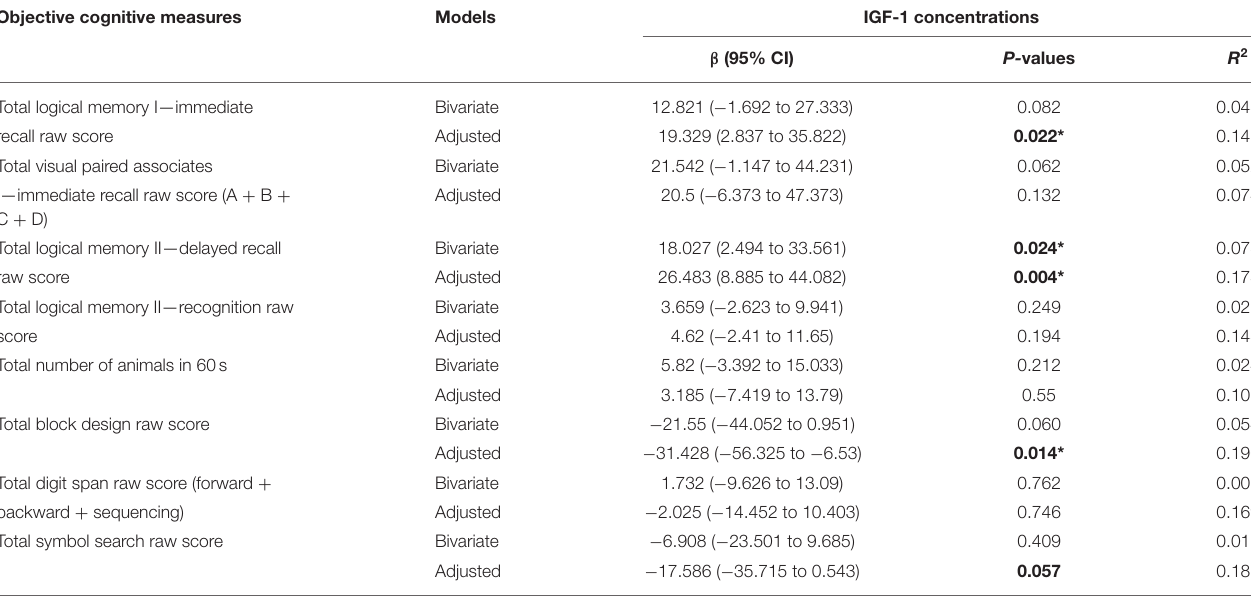
TABLE 2 | Associations between IGF-1 concentrations with objective cognitive measures. Objective cognitive